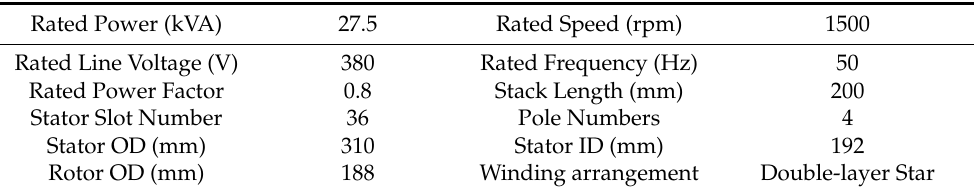
Table 3. Specifications of the prototype.